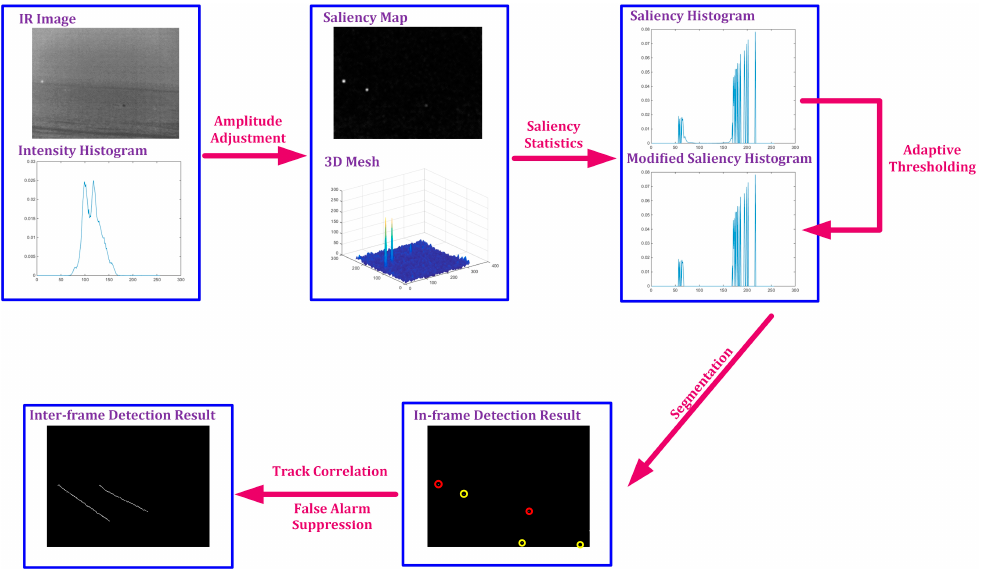
Figure 1. Flow chart of the presented method.